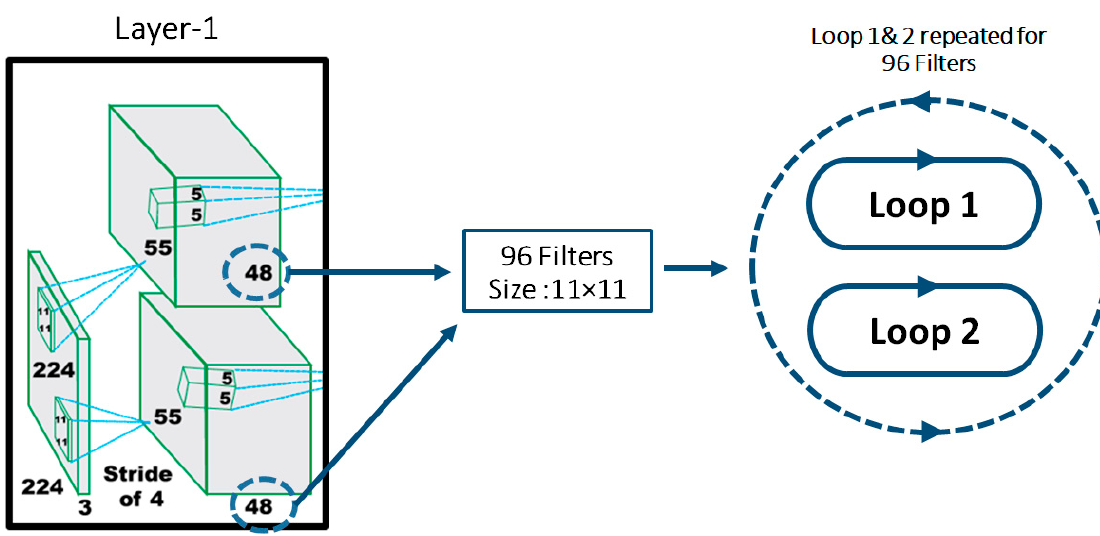
Figure 11. Total of 96 AlexNet Layer-1 filters with 48 filters each from the upper and lower pipeline.